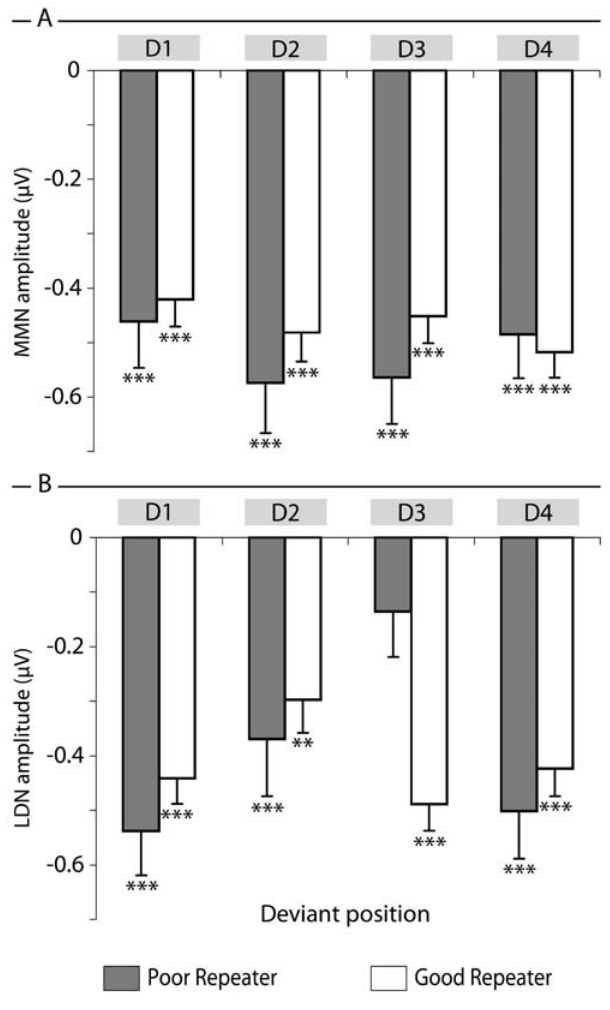
Figure 2. Comparison of mean MMN and LDN amplitudes for the six fronto-central electrodes. Mean amplitude of MMN (top panel) and LDN (lower panel) of the six analysed electrodes in relation to nonword repetition status and position of deviant syllable. Error bars show standard errors. Asterisks on the upper x-axis denote where the mean mismatch response differed significantly from zero on t-test, at p- values of .01 (**) or .001 (***).